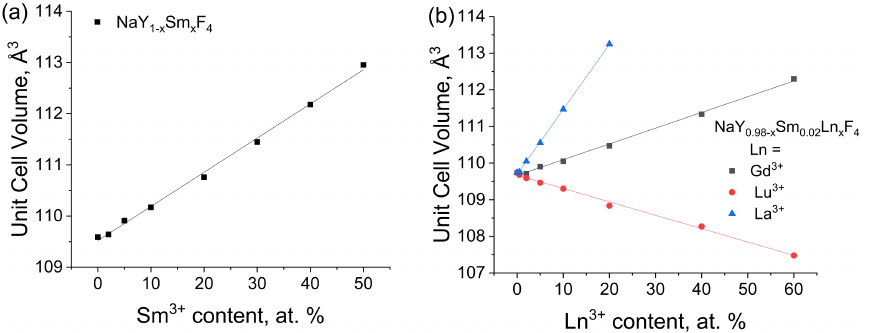
Figure 2. The dependence of unit cell volumes of NaY 1 − x Sm x F 4 on the Sm 3+ content ( a ) and NaY 0.98 − x Sm 0.02 Ln x F 4 (Ln = La, Gd, Lu) samples on the Ln 3+ content ( b